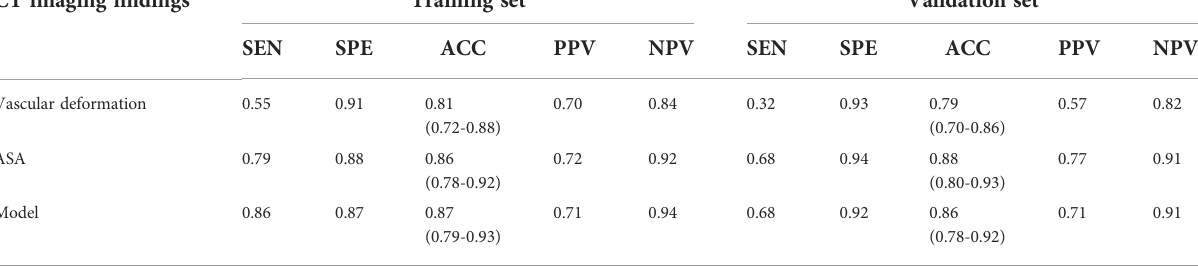
TABLE 3 Diagnostic performances of the CT imaging fi ndings.